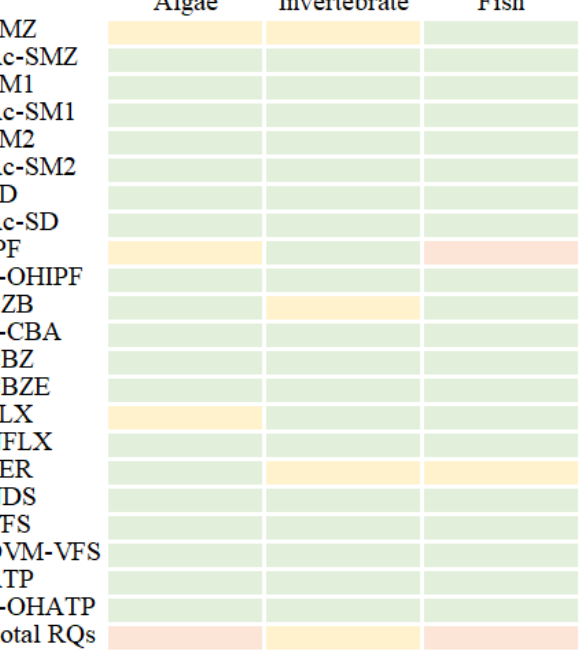
Figure 9. The risks of pharmaceutical metabolites and their parents to algae, invertebrates, and fish.